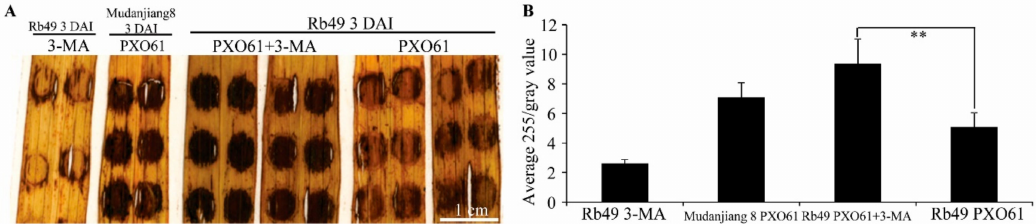
Figure 4. H 2 O 2 accumulation promoted by autophagy inhibitor 3-methyladenine in impaired Xa3 / Xa26- mediated resistance reaction. ( A ) DAB staining of Rb49 and Mudanjiang 8 leaves with inoculation sites infiltrated by Xoo strain PXO61 in H 2 O solution, in 3-methyladenine (3-MA) solution, and infiltrated with only 3-MA solution at 3 DAI. ( B ) Average H 2 O 2 content of inoculation site showed by 255 divided by gray value of inoculation site. Data represent mean (18-24 inoculation sites of 3 independent plants) + standard deviation. Double asterisks (**) indicate H 2 O 2 content statistically significant di ff erences ( p < 0.01) between Rb49 infiltrated with PXO61 in 3-MA solution and that in H 2 O solution.